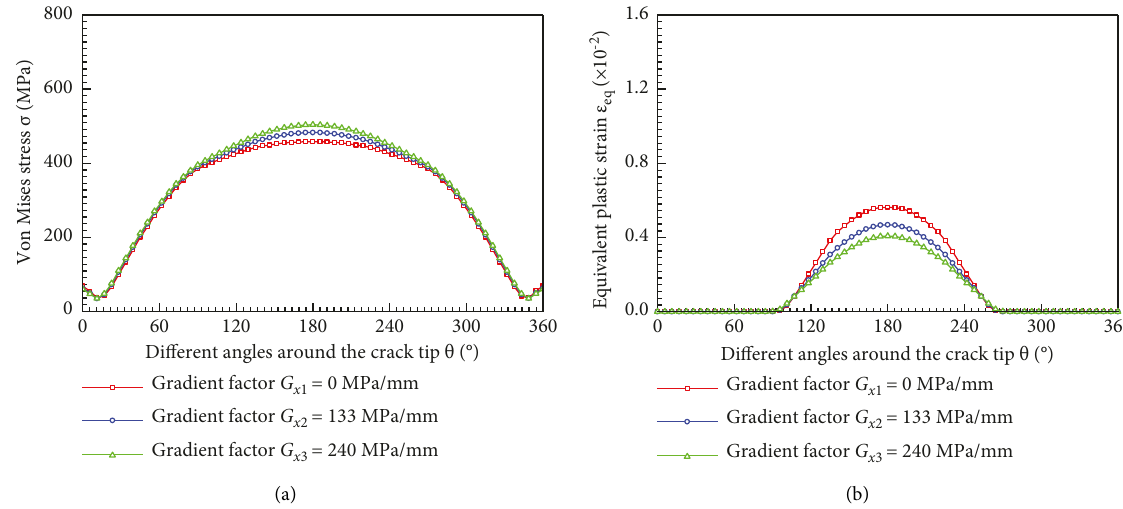
Figure 11: Curve of the USDFLD subroutine welded joint model whose yield strength changes in the x -direction. (a) Von Mises stress curve at crack tip. (b) Equivalent plastic strain curve at crack tip.